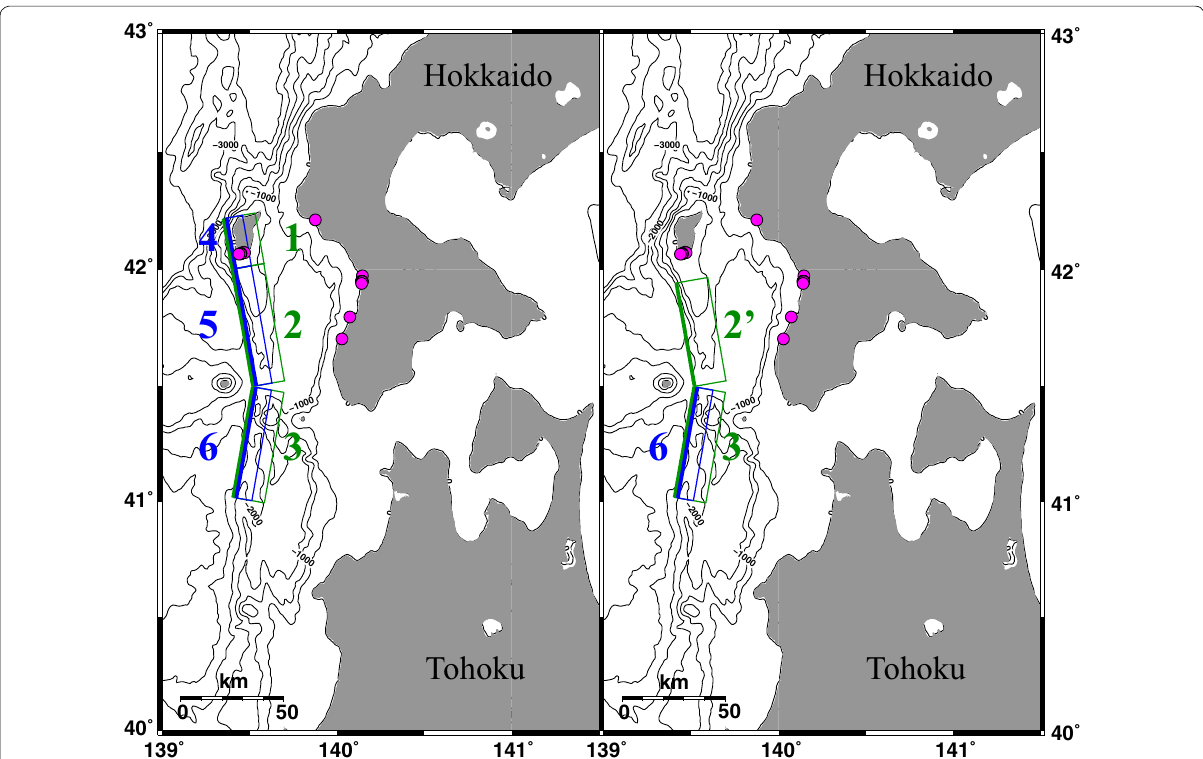
Fig. 2 Locations of subfaults are shown with a depth contour interval of 500 m. The left figure is fault model F17 used to calculate the anticipated inundation of the tsunami in the Japan Sea by the Hokkaido Disaster Management Council (2017). The right figure is the fault model estimated in this study. Detailed fault model parameters are provided in Tables 1 and 2. Tsunami deposit distributions are shown in pink